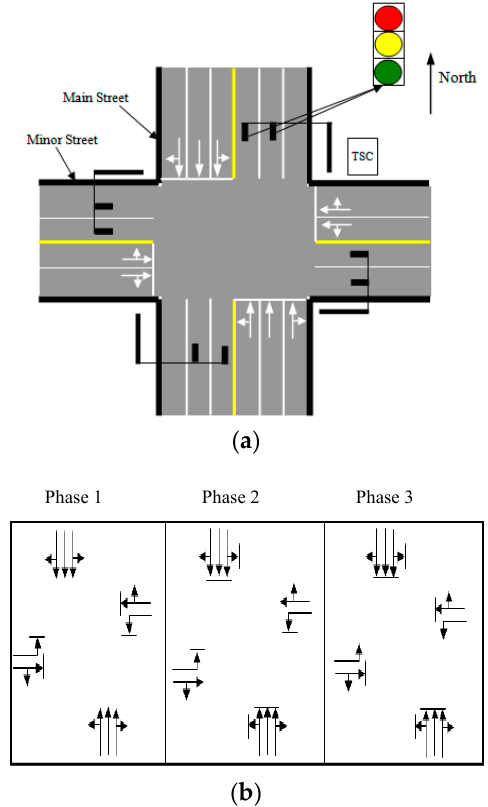
Figure 8. Control algorithm II intersection control model and its phases diagram: ( a ) Intersection control model. ( b ) Intersection signal control diagram.